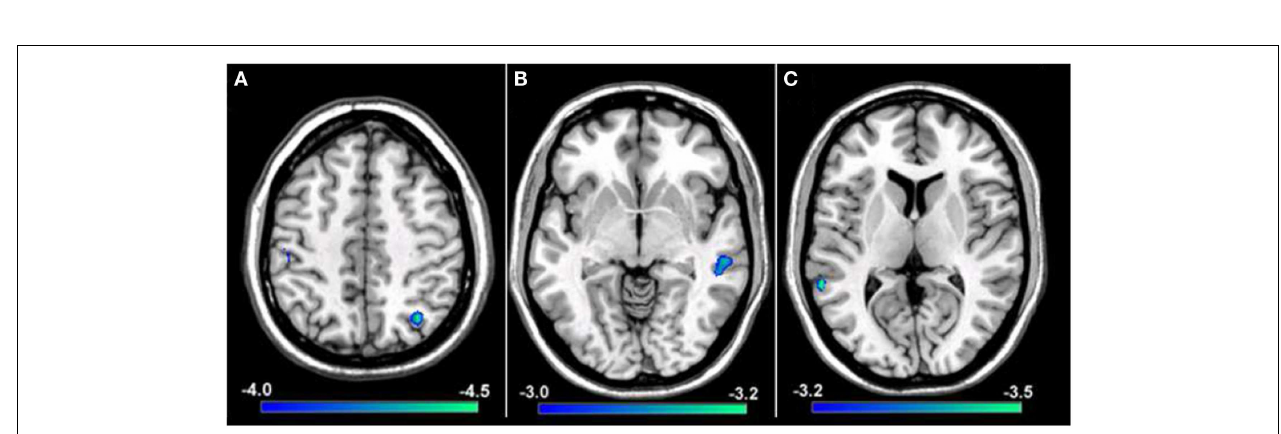
FIGURE 6 | Results from a group comparison between 11 patients with tspFHD and matched healthy controls for resting-state functional connectivity maps in the hemisphere representing the affected hand (left M1) . Reductions in resting-state connectivity in the tspFHD group are shown